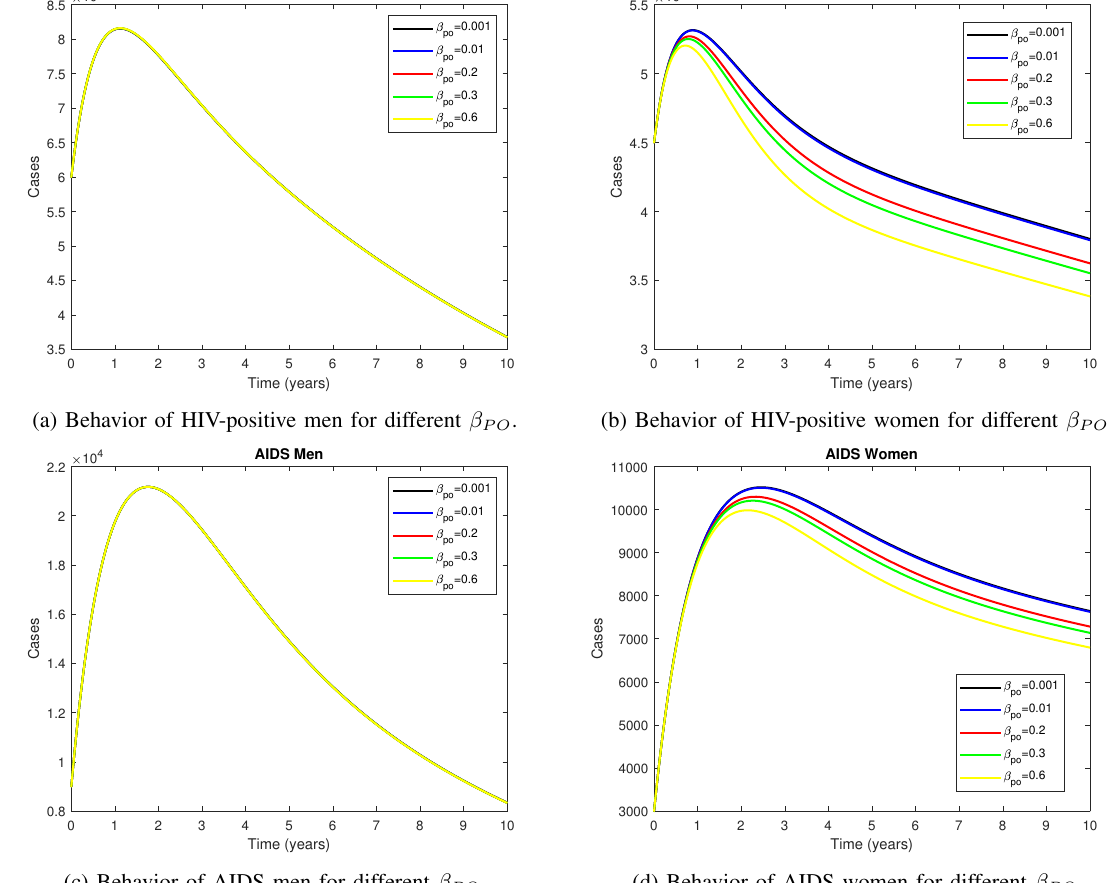
(d) Behavior of AIDS women for different β PO . Fig. 12: Study of the compartments of HIV and AIDS for different values of β PO